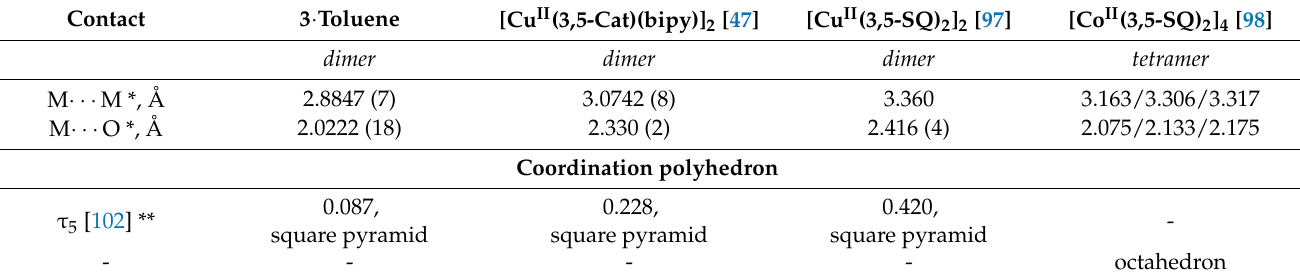
Table 1. In general, a formation of tetrameric structures is preferable for Co II compounds derived from o -benzoquinone type ligands, as 3,5-di- tert -butyl- o -benzoquinone [98] and higher degree of oxygen atoms’ shielding leads usually to monomeric species [104]. How-